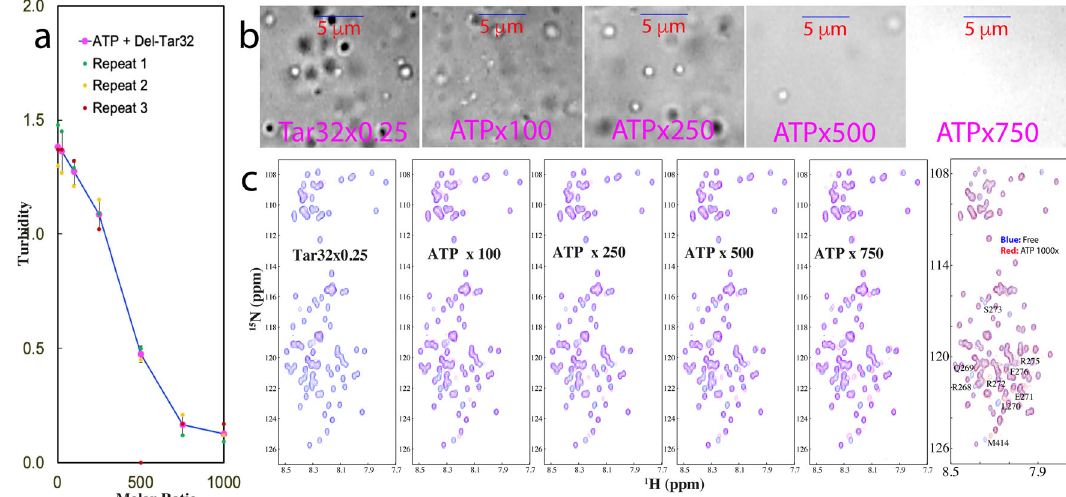
Fig. 4 ATP dissolves LLPS of Del-PLD maintained by Tar32. a Turbidity curve from three repeated measurements ( n = 3) of Del-PLD in the presence of Tar32 at 1:0.25, with further addition of ATP at different molar ratios. b DIC images of Del-PLD in the presence of Tar32 at 1:0.25, and with further addition of ATP at different molar ratios. c HSQC spectra of Del-PLD in the absence (blue) and in the presence of Tar32 at 1:0.25 (purple), as well as with further addition of ATP at different molar